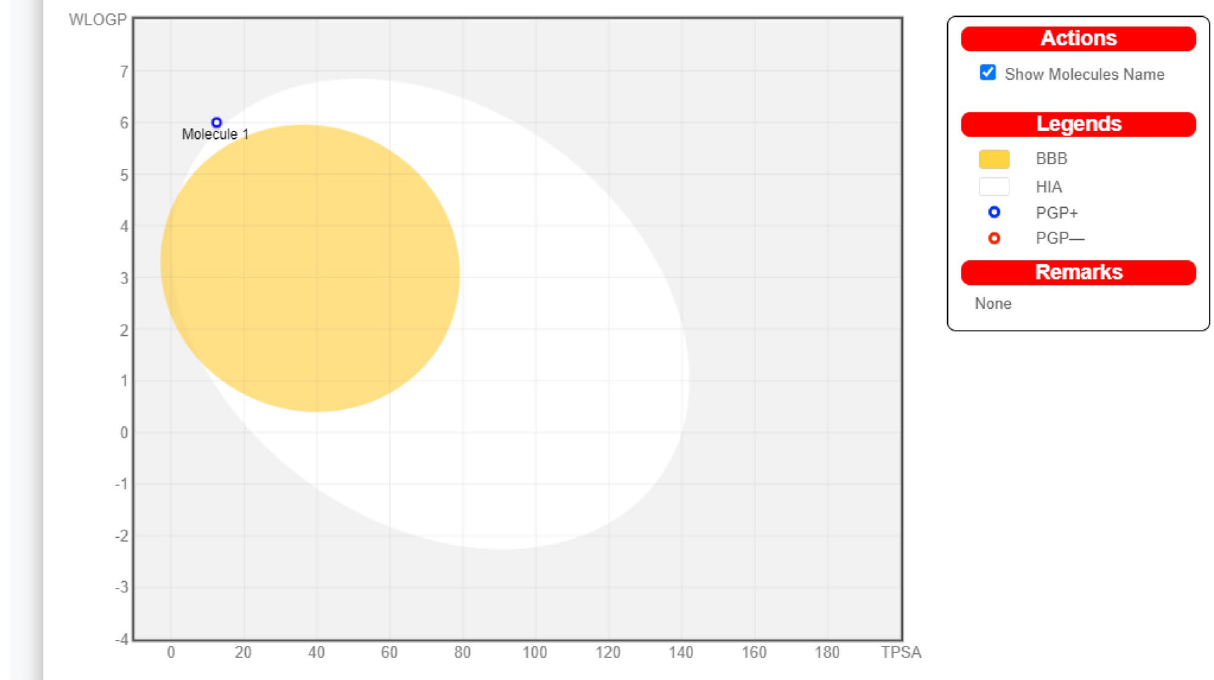
Figure 8. Tamoxifen boiled-egg model by